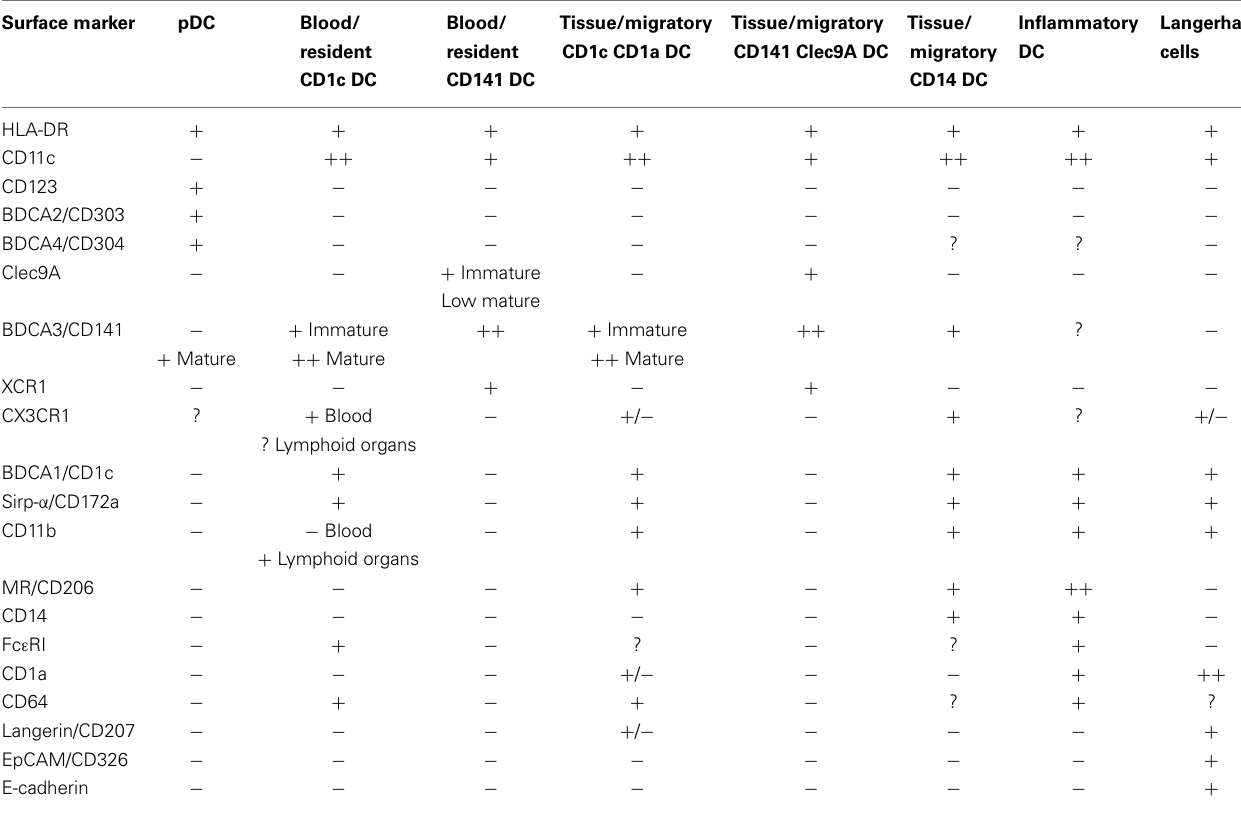
Table 1 | Phenotypic markers for human DC subsets . Surface